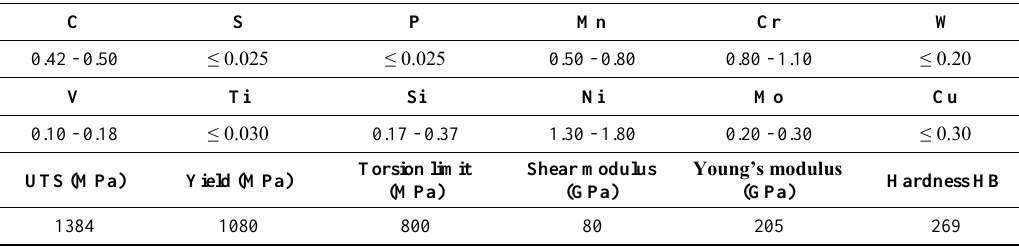
Table 2. Chemical composition and mechanical properties of the torsion bar material [10].